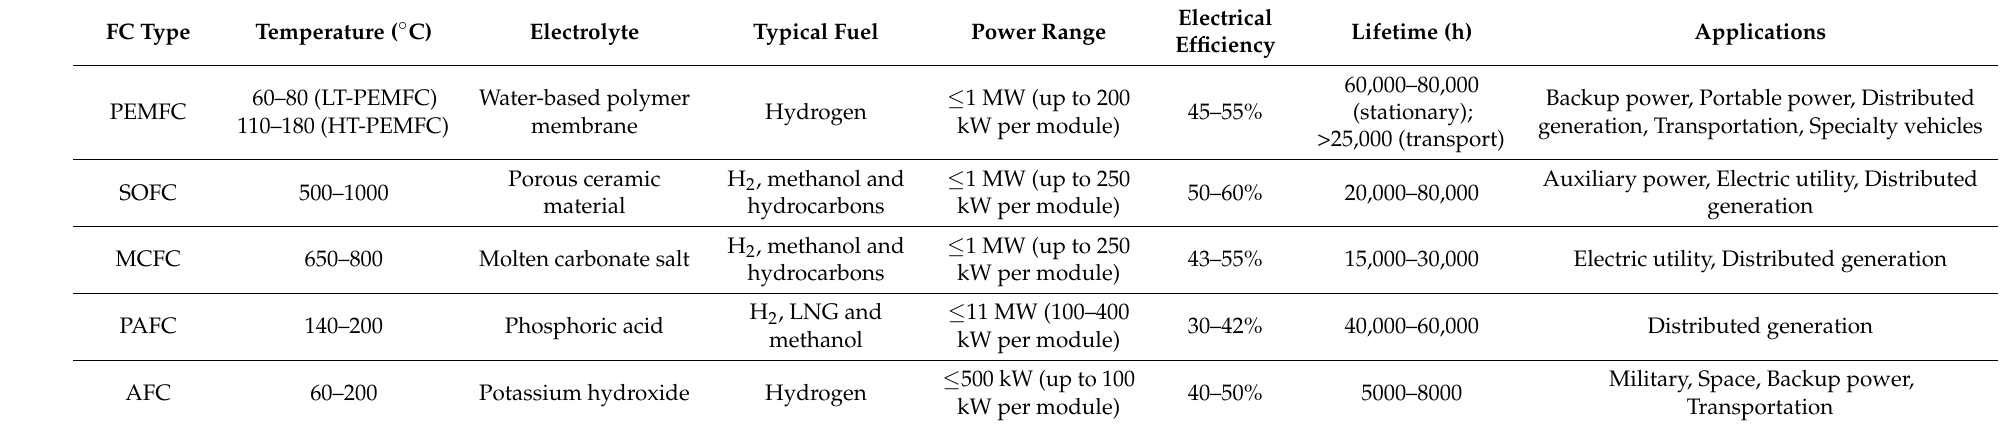
Table 1. Main fuel cell technologies and their characteristics